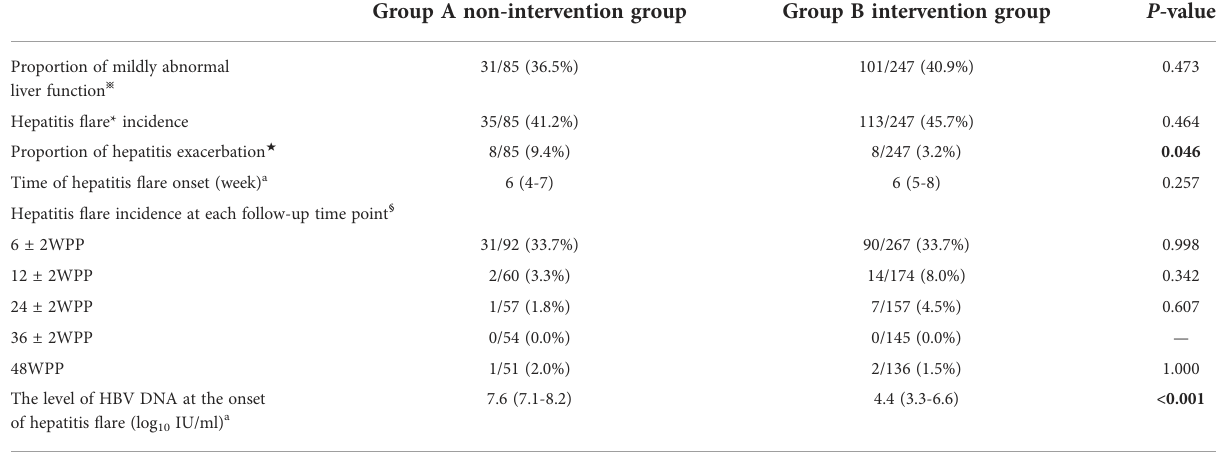
TABLE 4 Incidence of postpartum hepatitis fl are in the two